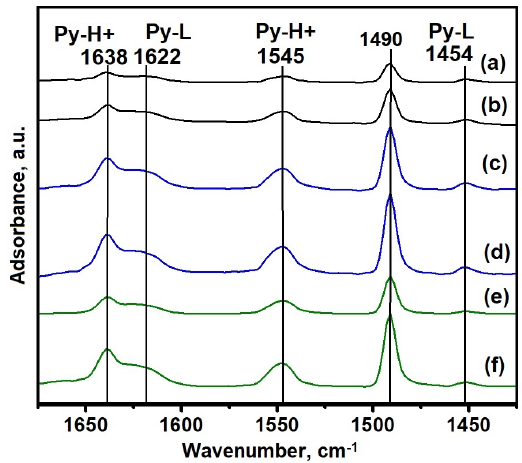
volume of mesopores.